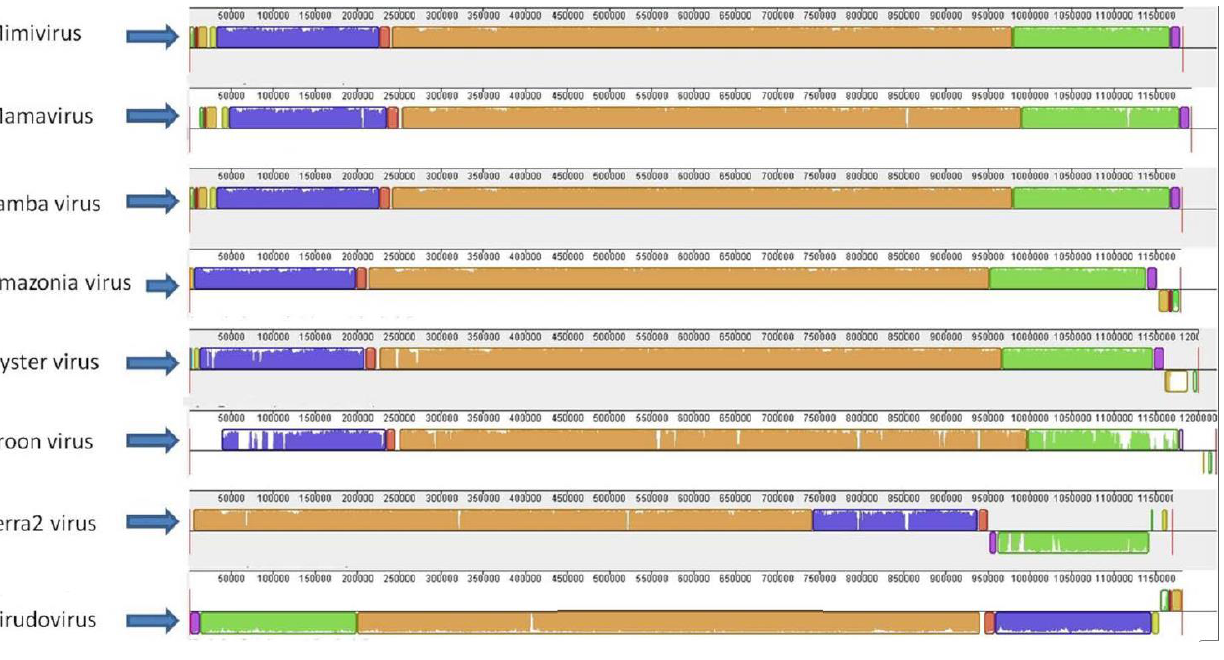
Figure 3. Genome alignment of lineage A amoebal mimiviruses showing their genome architecture and synteny. The genome alignment and schematic were obtained using the Mauve software package [32].